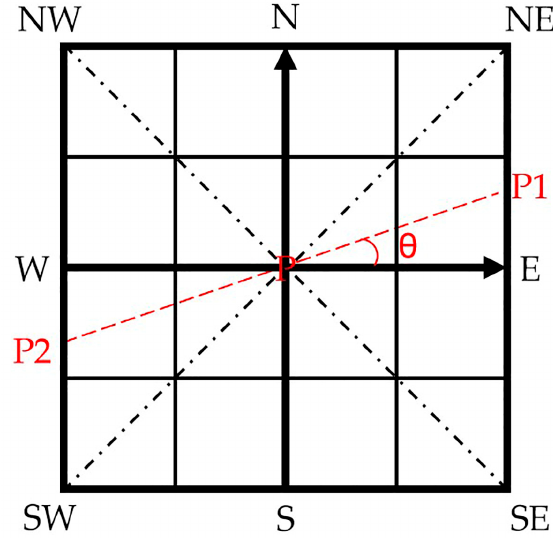
Figure 7. Schematic diagram of gradient direction.